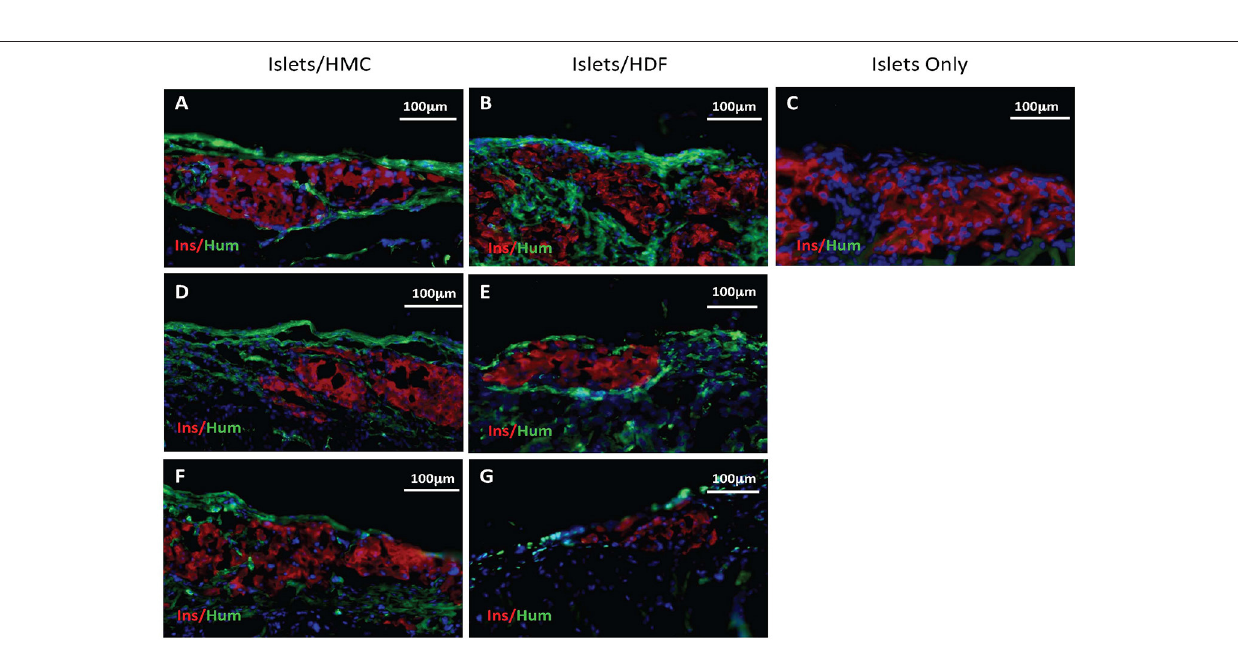
FIGURE 5 | Immunostaining for insulin in red and human nuclear antigen in green as a marker for HMCs or HDFs. Nuclear (DAPI) staining is in blue for all sections. (A,C) Sections from day 3 grafts post-transplant. (D,E) Sections from day 7 grafts post-transplant. (F,G) Sections from day 14 grafts post-transplant. (A,D,F) Islets/HMC sections, (B,E,G) Islets/HDF sections. (C) Section from day 3 post-transplant Islets Only graft. Magnification 200 ×